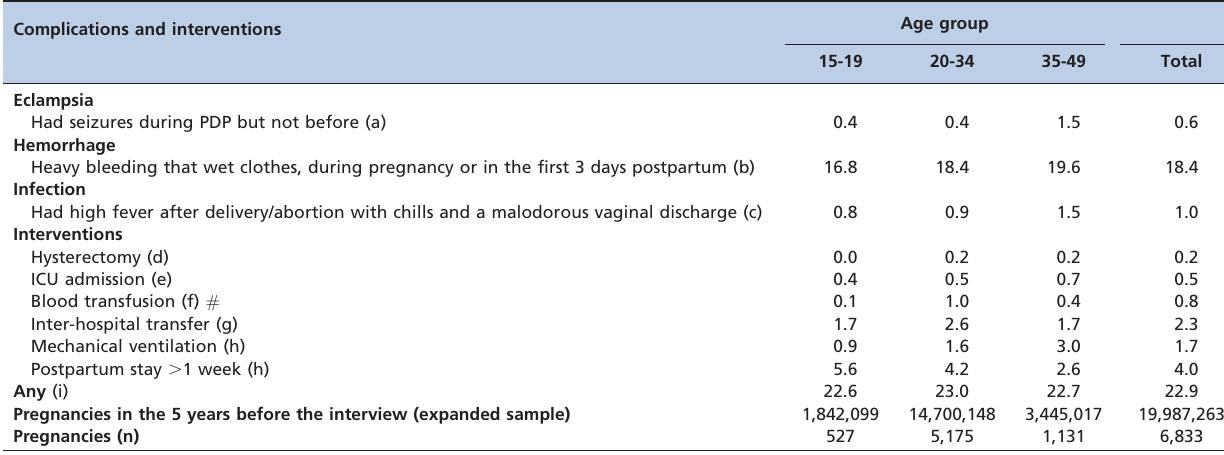
Table 2 - Proportion of pregnancies* with complications and related interventions by age group. DHS, Brazil, 2006. Complications and